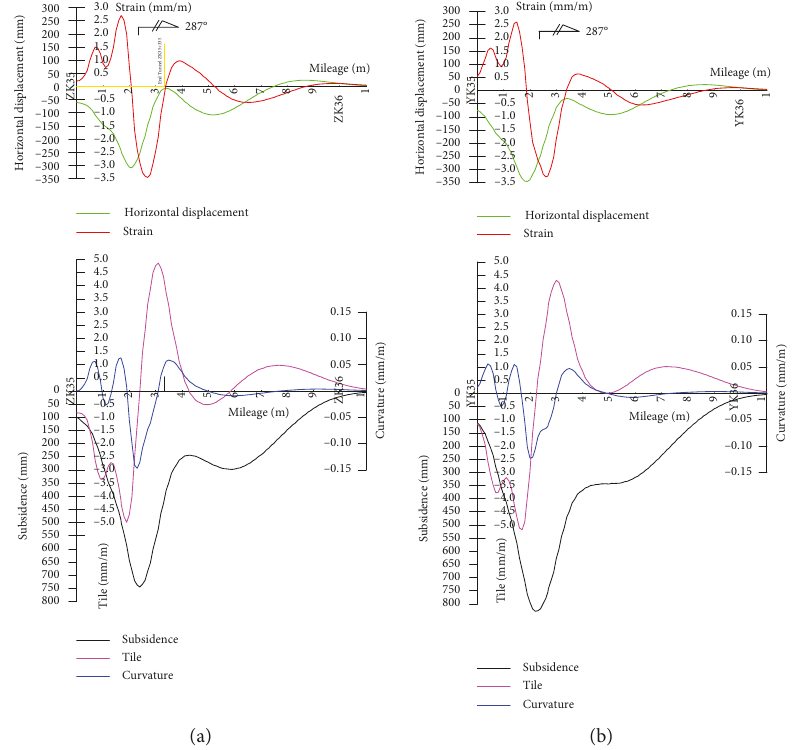
Figure 16: Tunnel deformation in condition of all coal resource excavated. (a) Left tunnel. (b) Right tunnel.